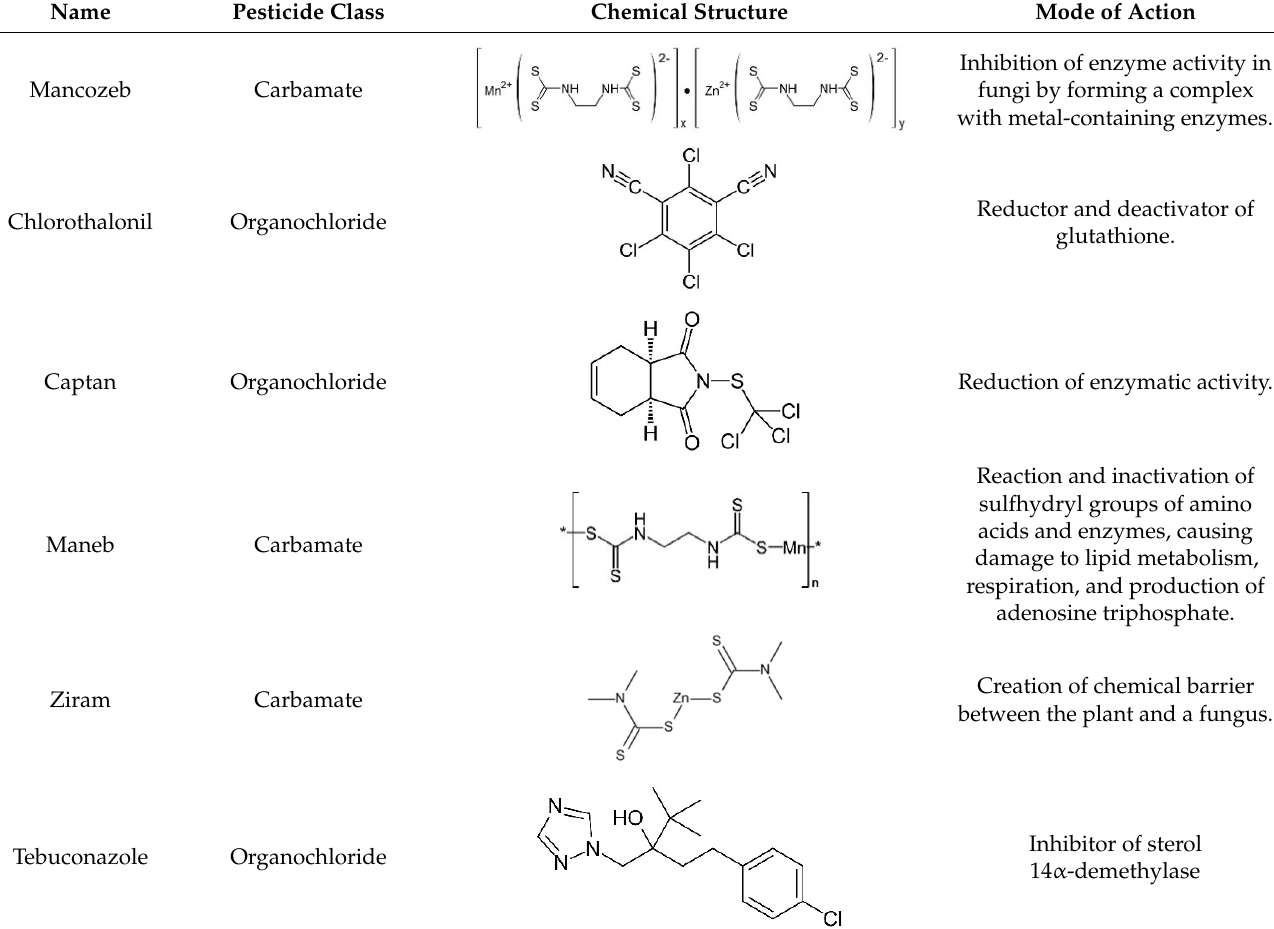
Table 6. Classification of the most common fungicides used in agricultural soil.